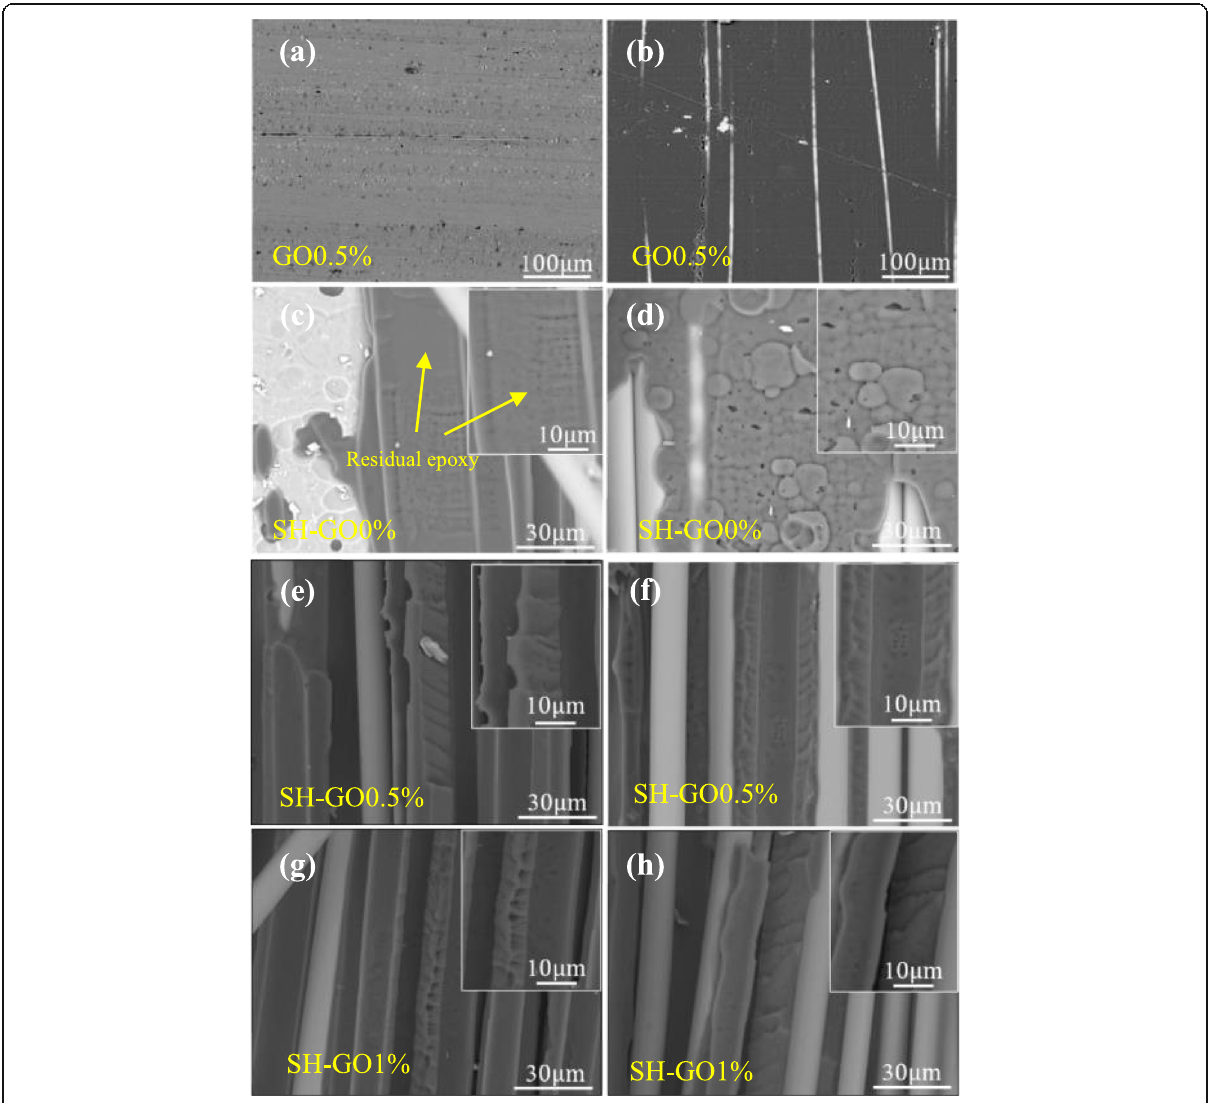
Fig. 14 Fracture surfaces of mode-I GFRP/Al laminates. a, b GO0.5%. c , d SH-GO0%. e , f SH-GO0.5%. g , h SH-GO1% (left, the Al side; right, the composite